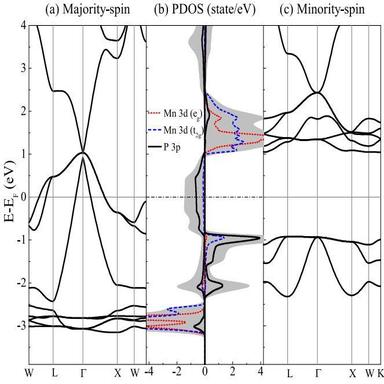
Spin-resolved band structure and partial density of states of ZB-MnP at the expanded lattice parameter a ¼ 6:73 Å. The shaded regions represent the total density of states.